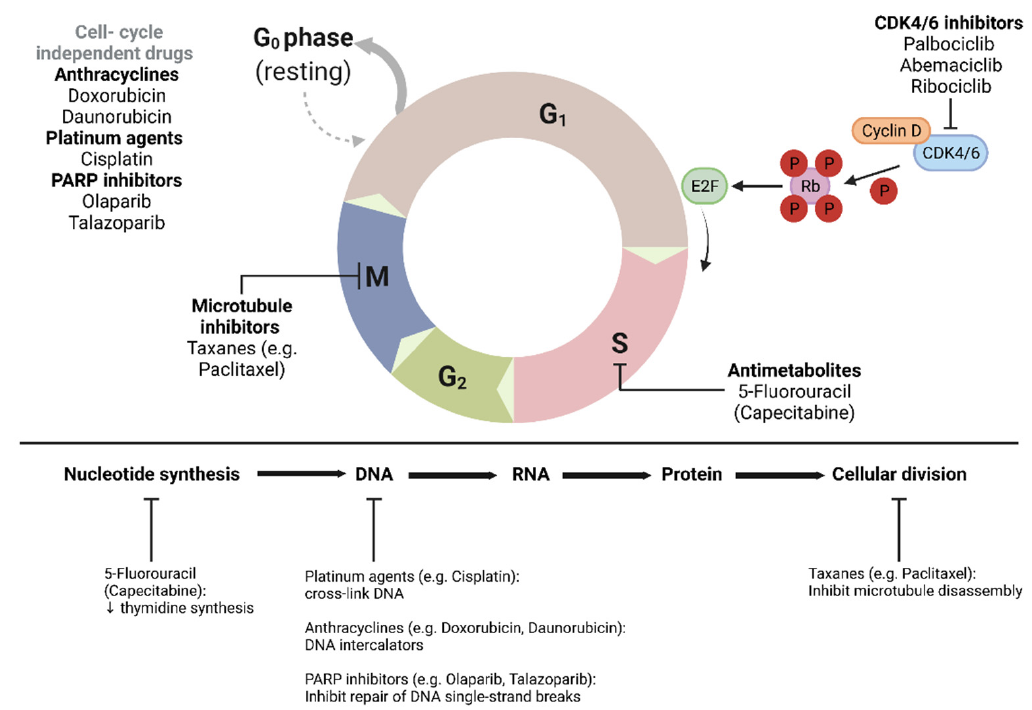
Figure 2. Cell cycle targets of chemotherapy and novel drugs.